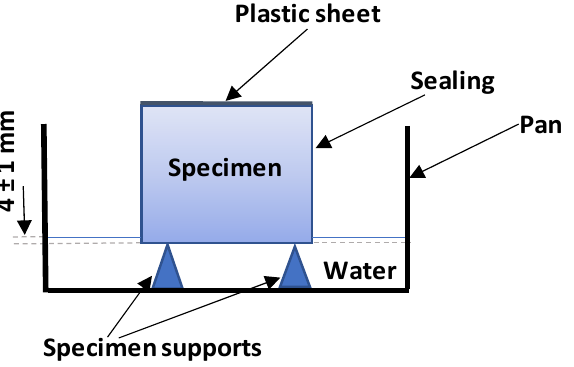
Figure 2. The schematic diagram of the capillary absorption test.